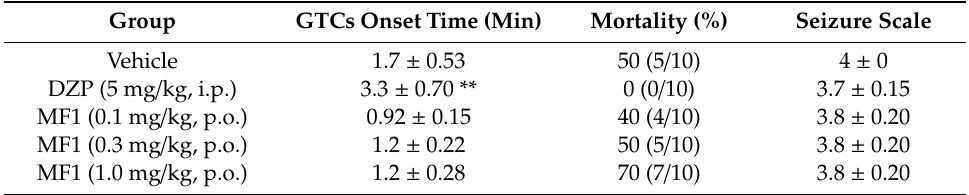
Table 1. Acute e ff ects of MF1 and DZP on epileptic seizure in PTZ-treated mice. ** p < 0.01 vs. vehicle-administered PTZ-treated mice. ( n = 10 per group). GTCs: generalized tonic-clonic seizures,